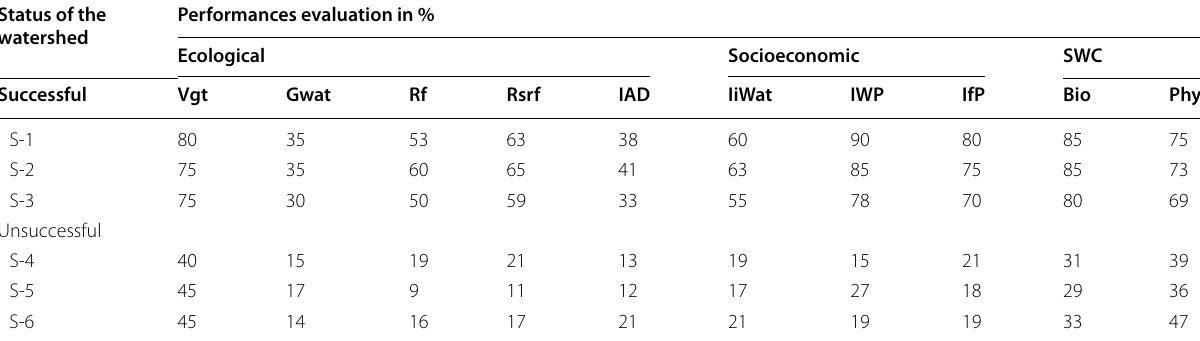
Vgt: vegetation cover; Gwat: Ground water recharge; Rf: Reducing flooding: Rsrf; Reducing surface runoff: IAD: Increase animal diversity; IiWat: Increased irrigation water availability; IWP; Increased women participation; IfP: increased fodder production; Bio: biological; Phy: physical; S-1 Negash; S-2: Deberewahabit; S-3 Gemad; S-4 Debretsion; S-5 Laelay wukro; S-6 Tsigerda